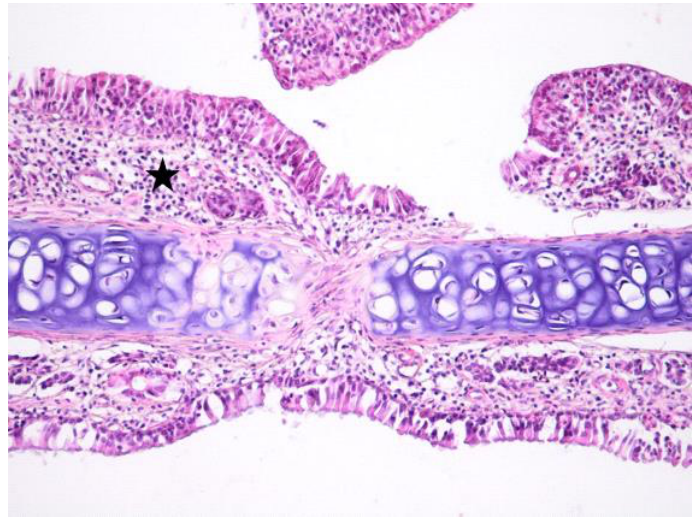
Figure 5. Light micrographs of the rat’s nasal septum, dexamethasone group, at 14 days after the intranasal intervention. The lamina propria of the mucosa covering the nasal septum is moderately expanded and the nasal glands are replaced by lymphocytes, macrophages and plasma cells (black star). H&E, ob ×20.